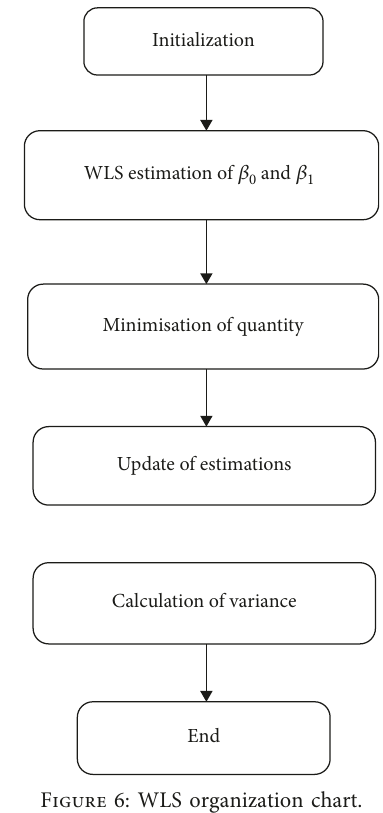
Figure 6: WLS organization